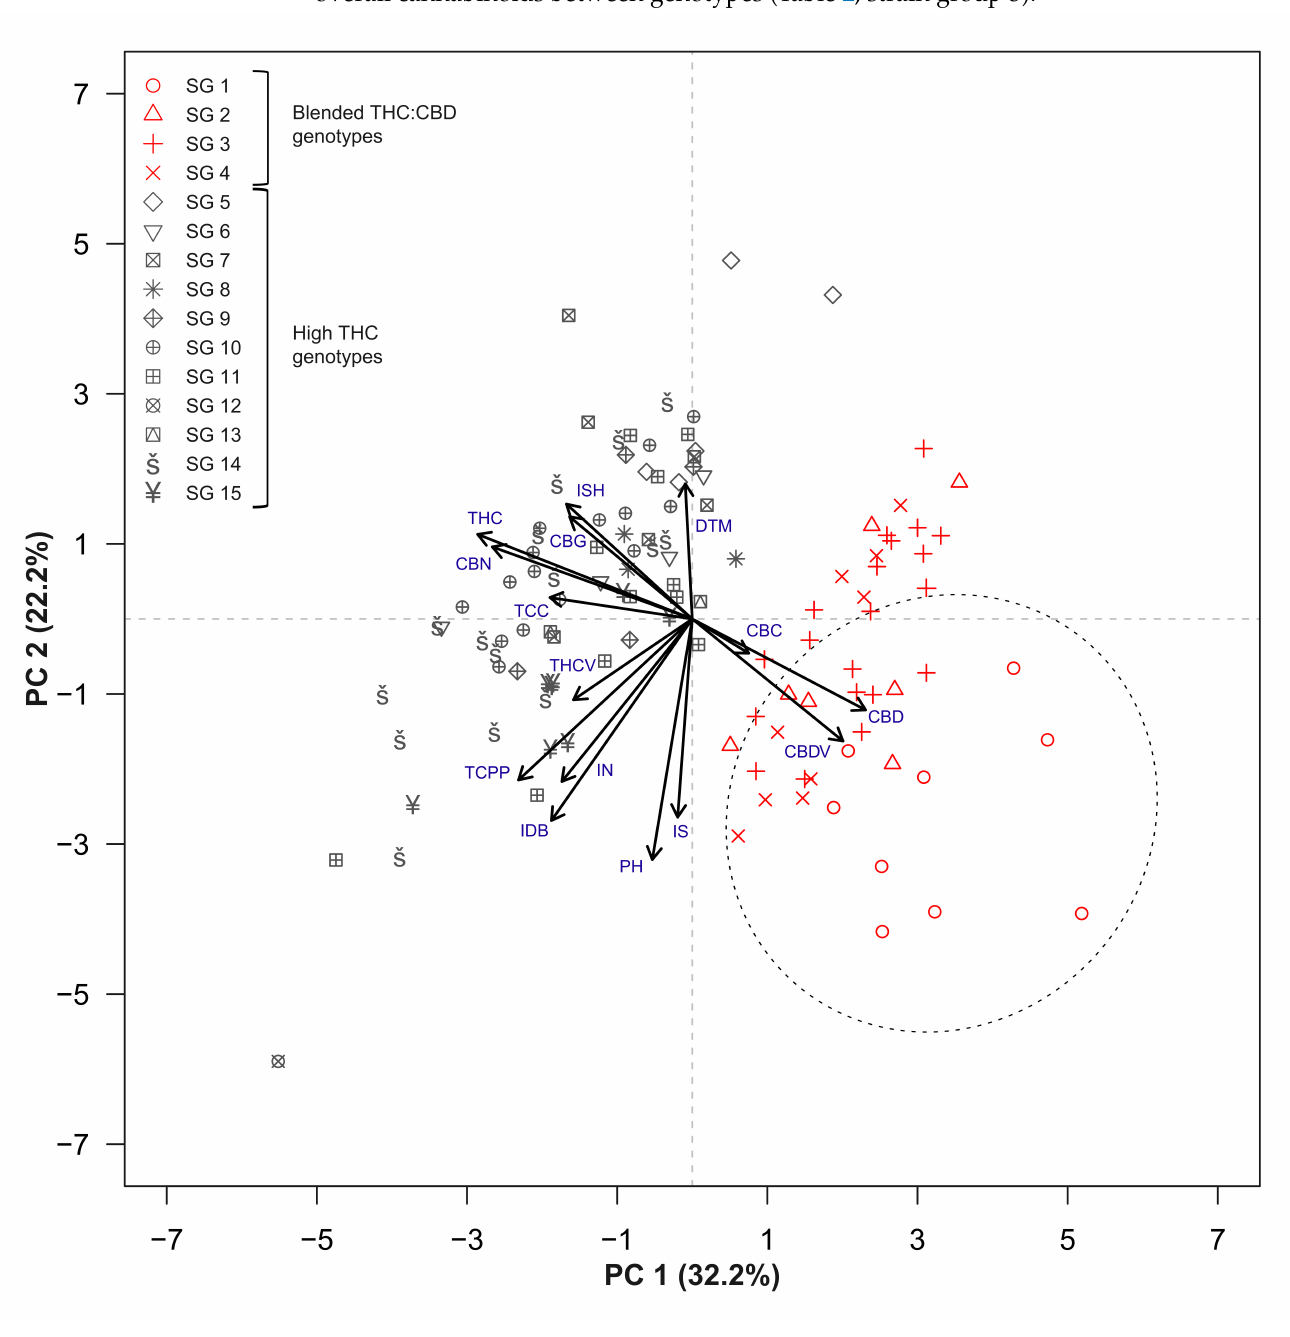
Figure 2. Principal component analysis (PCA) for the association between cannabinoid content, plants phenology, inflorescences morphology and key physiological attributes across 119 drug-type cannabis genotypes. Red symbols and black symbols indicate blended THC:CBD and high-THC genotypes, respectively. Symbol shapes specify the genotypic vernacular classification into strain groups (SG, such as “Northern Lights”, “Purple Kush” and “Sour Diesel”). The ellipse marked over the biplot’s 1st and 4th quadrants represents a 95% confidence level for genotypes classified to SG1 (red circle symbols), a group comprising accessions obtained from crossing a blended CBD:THC drug-type plant and an off-type hemp plant. Abbreviations: total cannabinoids per plant